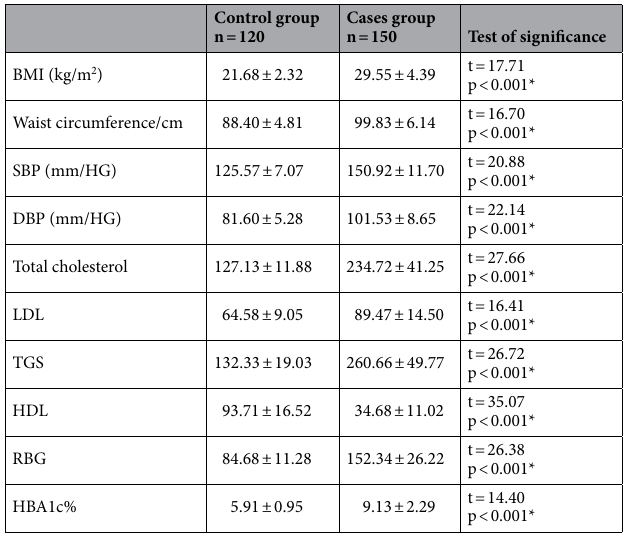
Table 3. Comparison of metabolic findings between studied groups. t: Student t test *statistically significant, parameters described as mean ± SD. BMI body mass index, SBP systolic blood pressure, DBP diastolic blood pressure, TGS triglycerides, HDL high density lipoprotein, RBG random blood glucose, HBA1c hemoglobin